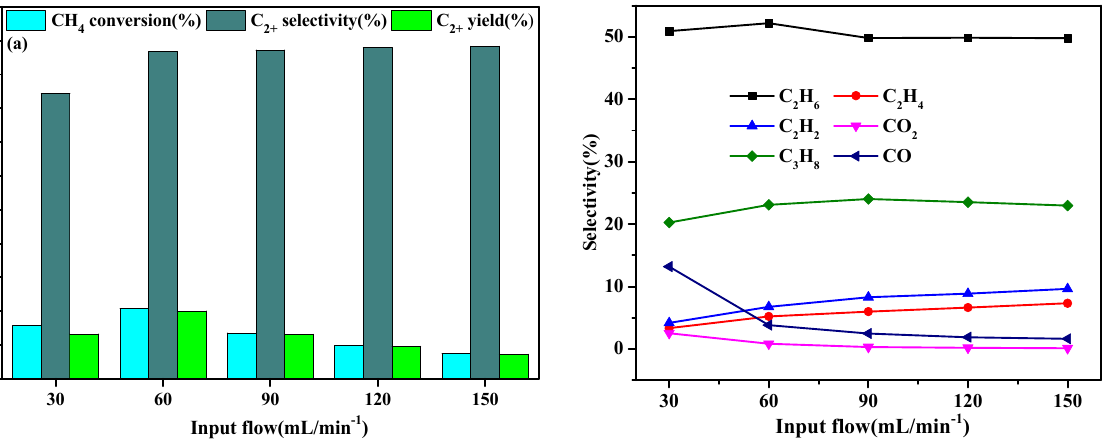
Figure 5. Effect of flow rate on the catalytic performance of the MnTi catalyst in DBD plasma. ( a ) Oxidative coupling performance; ( b ) product distribution (temperature: ambient temperature, applied voltage: 100